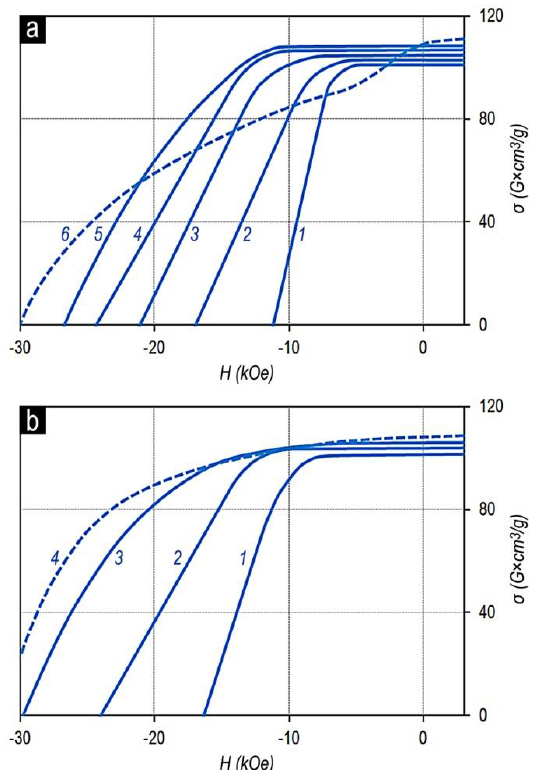
Figure 2. Magnetization reversal portions of major hysteresis loops of pseudo-single crystal samples in high-coercivity state: ( a ) Sm 0.85 Zr 0.15 (Co 0.702 Cu 0.088 Fe 0.210 ) z with z = 6.0 (1); 6.2 (2); 6.3 (3); 6.4 (4); 6.5 (5) and 6.8 (6), and ( b ) Sm 1-X Zr X (Co 0.702 Cu 0.088 Fe 0.210 ) 6.4 with х = 0.13 (1); 0.15 (2); 0.17 (3) and 0.19 (VSM, without allowance for the demagnetizing factor, N = 1/3).